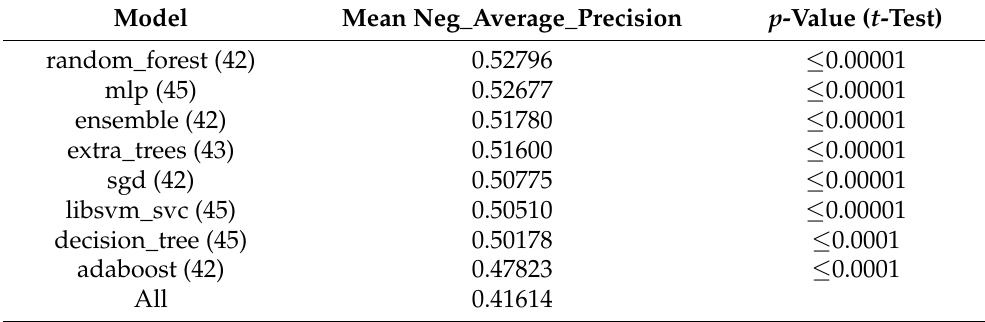
Table A5. Models with significantly better mean negative average